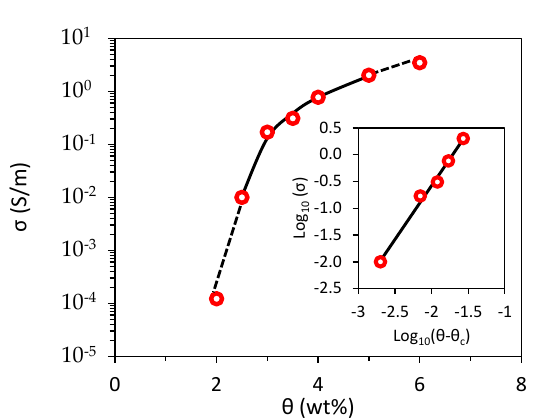
Figure 11. Electrical conductivity of the coatings as function of the GNP weight fraction.